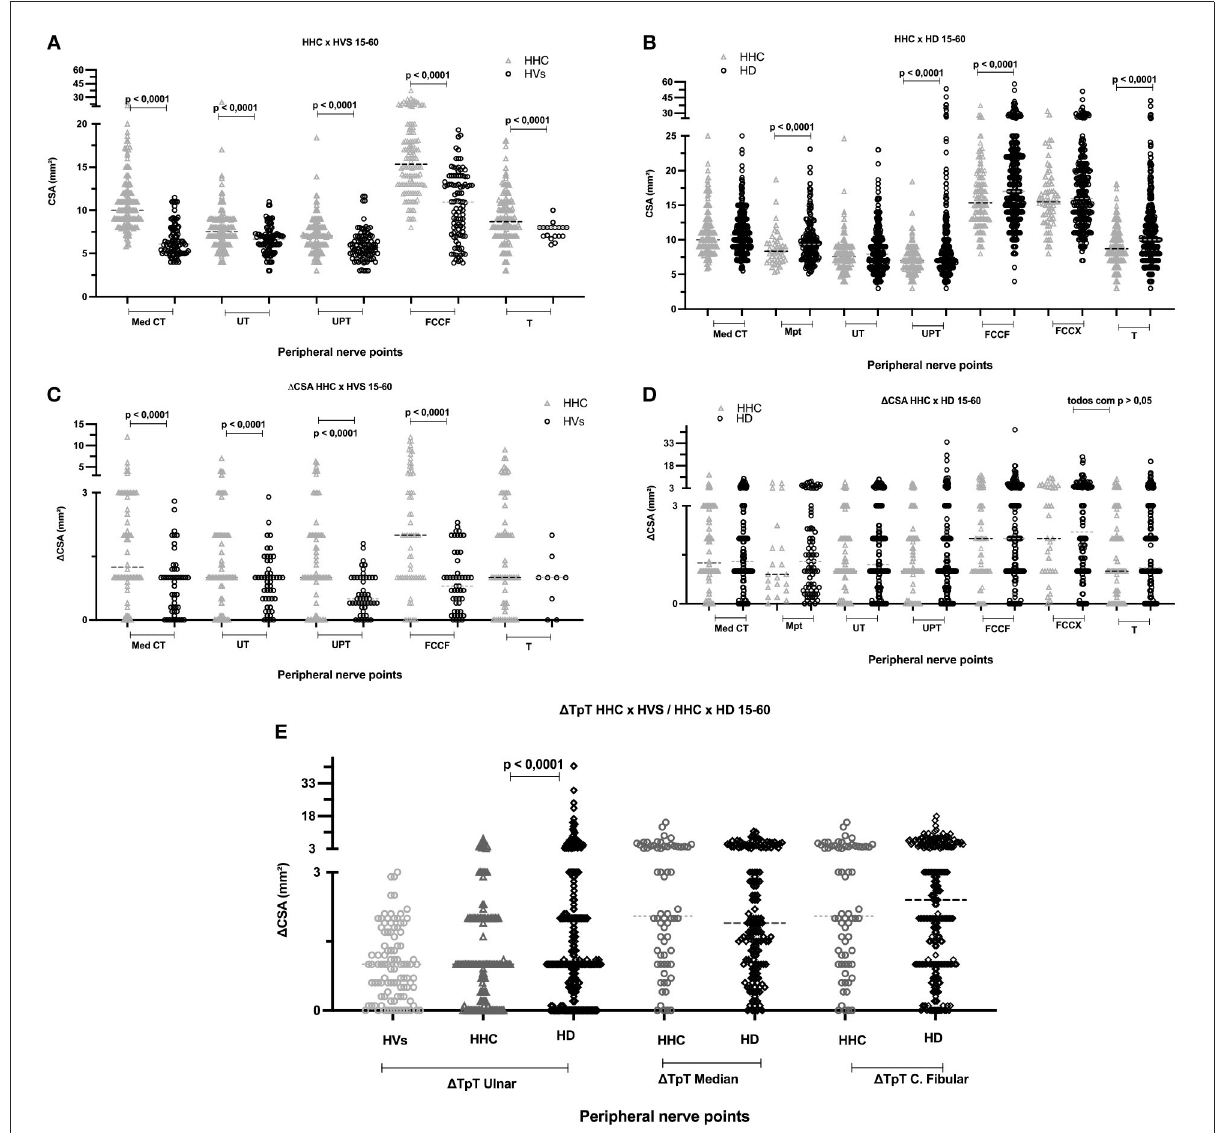
FIGURE2 Absolute CSA values (mm 2 ) of peripheral nerve sites for HVs and HHC [ (A) up on the left]; absolute CSA values of peripheral nerves sites for HHC and HD [ (B) up on the right]. 1 CSA (mm 2 ) of right and left sides at the same assessment site for HVs and HHC [ (C) middle on the left]; 1 CSA (mm 2 ) of right and left sides at the same assessment site for HHC and HD [ (D) middle on the right]. 1 TpT (mm 2 ) of the different sites of the same nerve for HVs, HHC, and HD [ (E) below]. (n), number; Med, median; CT, carpal tunnel; UT, ulnar tunnel; UPT, ulnar pre-tunnel; CFFH, common fibular nerve in the fibula head; T, tibial; MpT, median nerve in the proximal carpal tunnel; CFpFH, common fibular nerve proximal to the fibular head; CSA, cross-sectional area; 1 CSA, difference between the right and left nerves at the same site of assessment; 1 TpT, difference between the same nerve at different sites; HVs, healthy volunteers; HHC, household contacts of patients with HD; HD, Hansen’s disease.